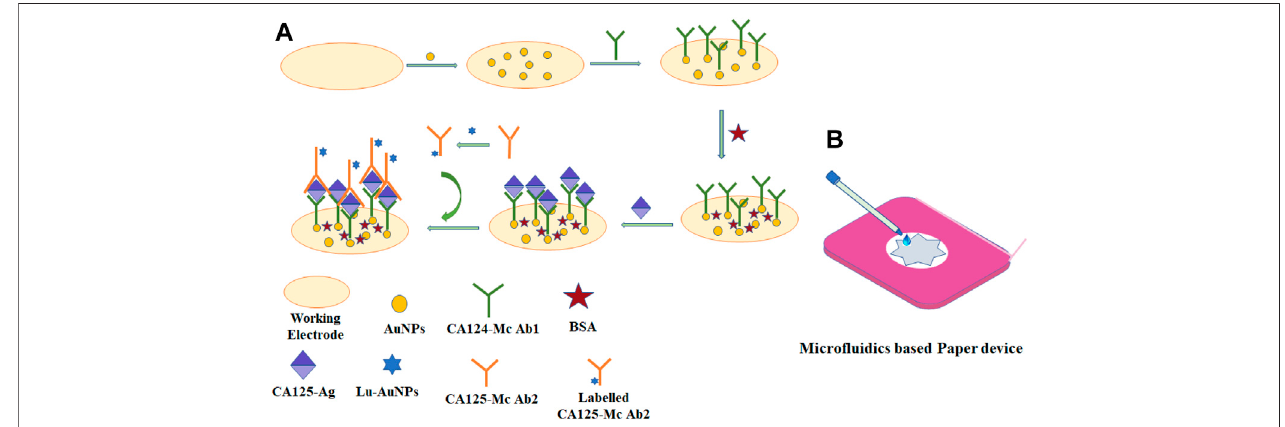
FIGURE 4 | Schematic representation of (A) fabrication of the ECL immunosensor and assay procedure and (B) 3D micro fl uidic origami immunodevice with transparent device-holder.